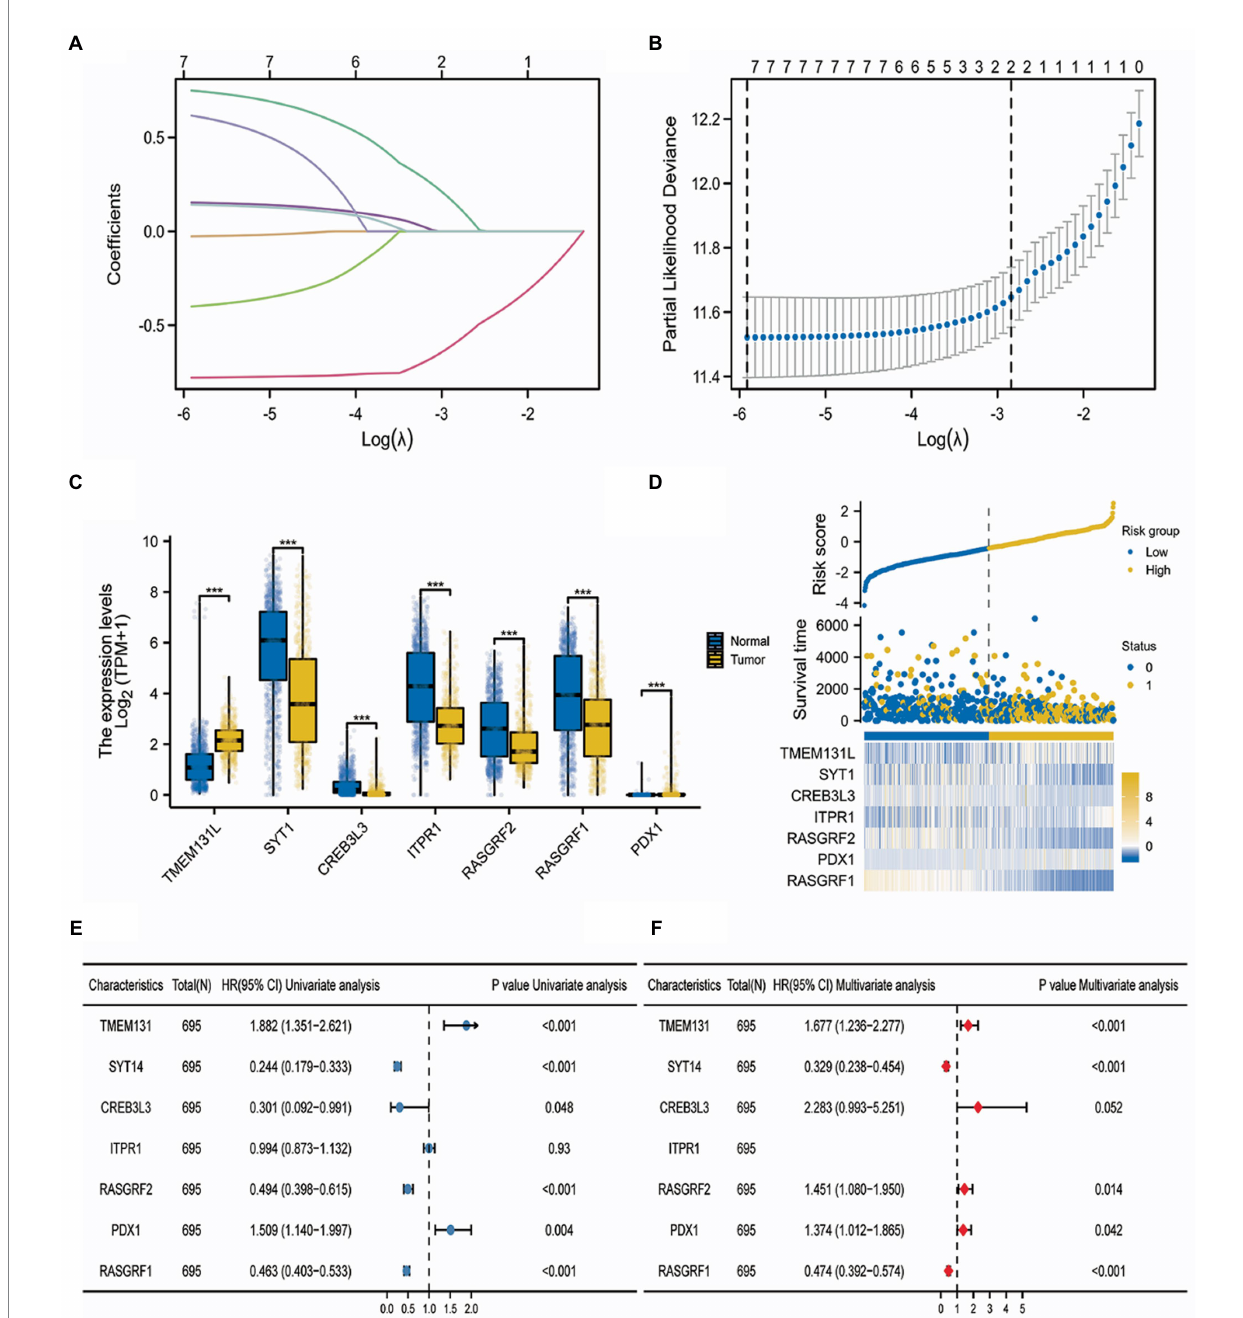
FIGURE 12 LASSO risk regression model construction. (A) LASSO logistic regression algorithm for screening diagnostic markers for lambda visualization; (B) min value visualization of diagnostic markers screened by LASSO logistic regression algorithm; (C) The expression difference of TMEM131L and Hub gene in glioma; (D) Risk curve of risk gene set (top), survival state (middle), and risk heat map (bottom); (E) Forest maps of univariate analysis of clinicopathological features of GBM and LGG with risk gene models; and (F) Multivariate analysis of clinicopathological features of GBM and LGG with risk gene